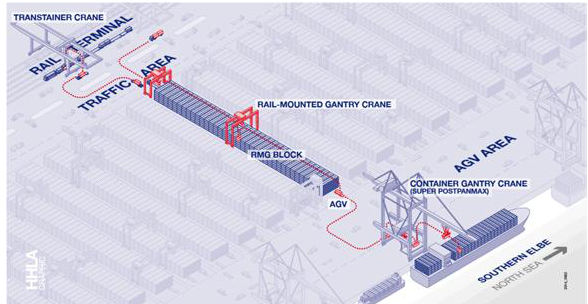
guideline or the specification of the cranes. A tolerance of +/- 10mm applies to the track location and the height tolerance is +/- 100mm.